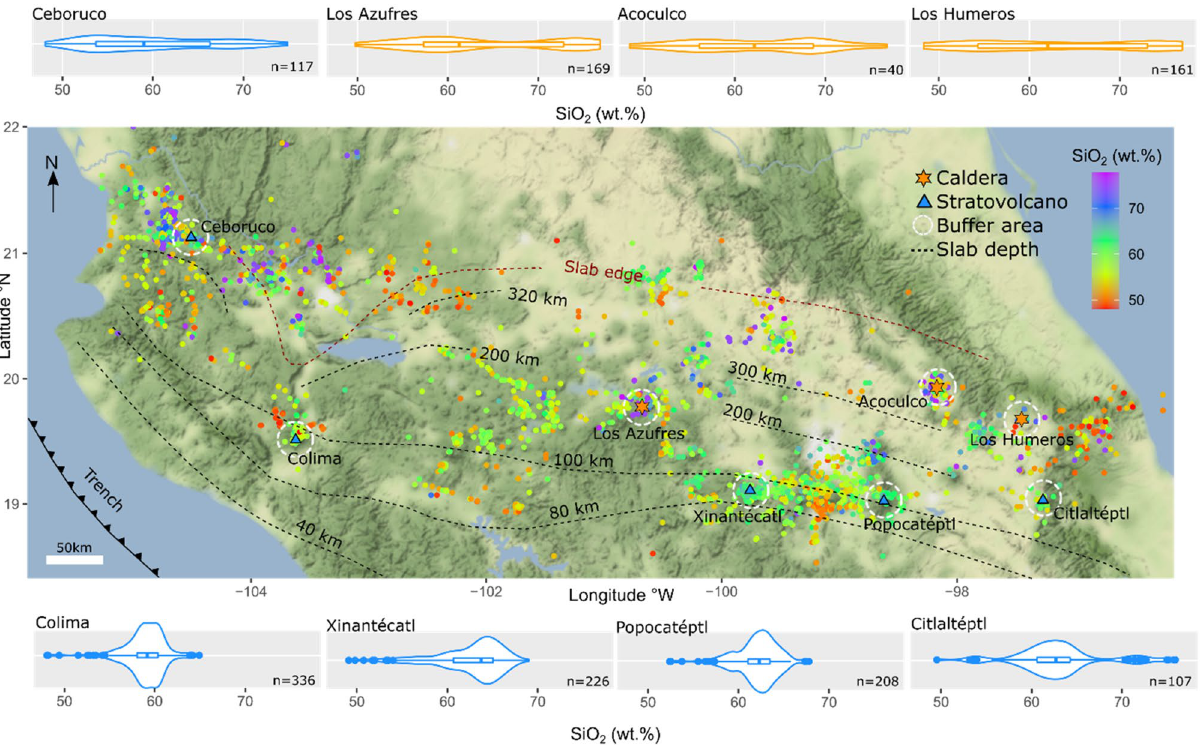
Figure 5. Spatial distribution of SiO 2 contents (wt%) in bulk-volcanic rock analysis of the Trans Mexican Volcanic Belt. Points on the map show the location of bulk-rock analysis from the GEOROC database, colour coded for their SiO 2 content. The location of calderas is marked by orange stars, stratovolcanoes are shown by blue triangles. Only volcanoes with constrained eruptive history are shown. Dashed circles (30 km buffer area) surrounding the volcanoes indicate the area, in which analyses were included to calculate the compositional distributions. Slab depths were taken from reference 23 . Colour of the density distributions reflects volcano type (stratovolcano: blue; caldera: orange). The map was created using the ggpmap package in R. Terrain Map tiles by Stamen Design, under CC BY 3.0., and map data by OpenStreetMap, under